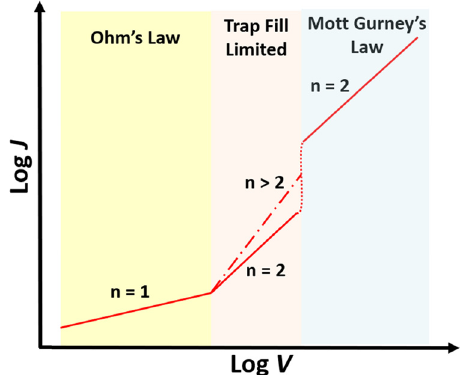
Figure 9: Schematic of a theoretical full logarithmic plot of the current density – voltage ( J – V ) with three distinct carrier conduction regions, namely Ohm ’ s law, trap - fi ll - limited, and Mott – Gurney ’ s law with their respective slopes of n .